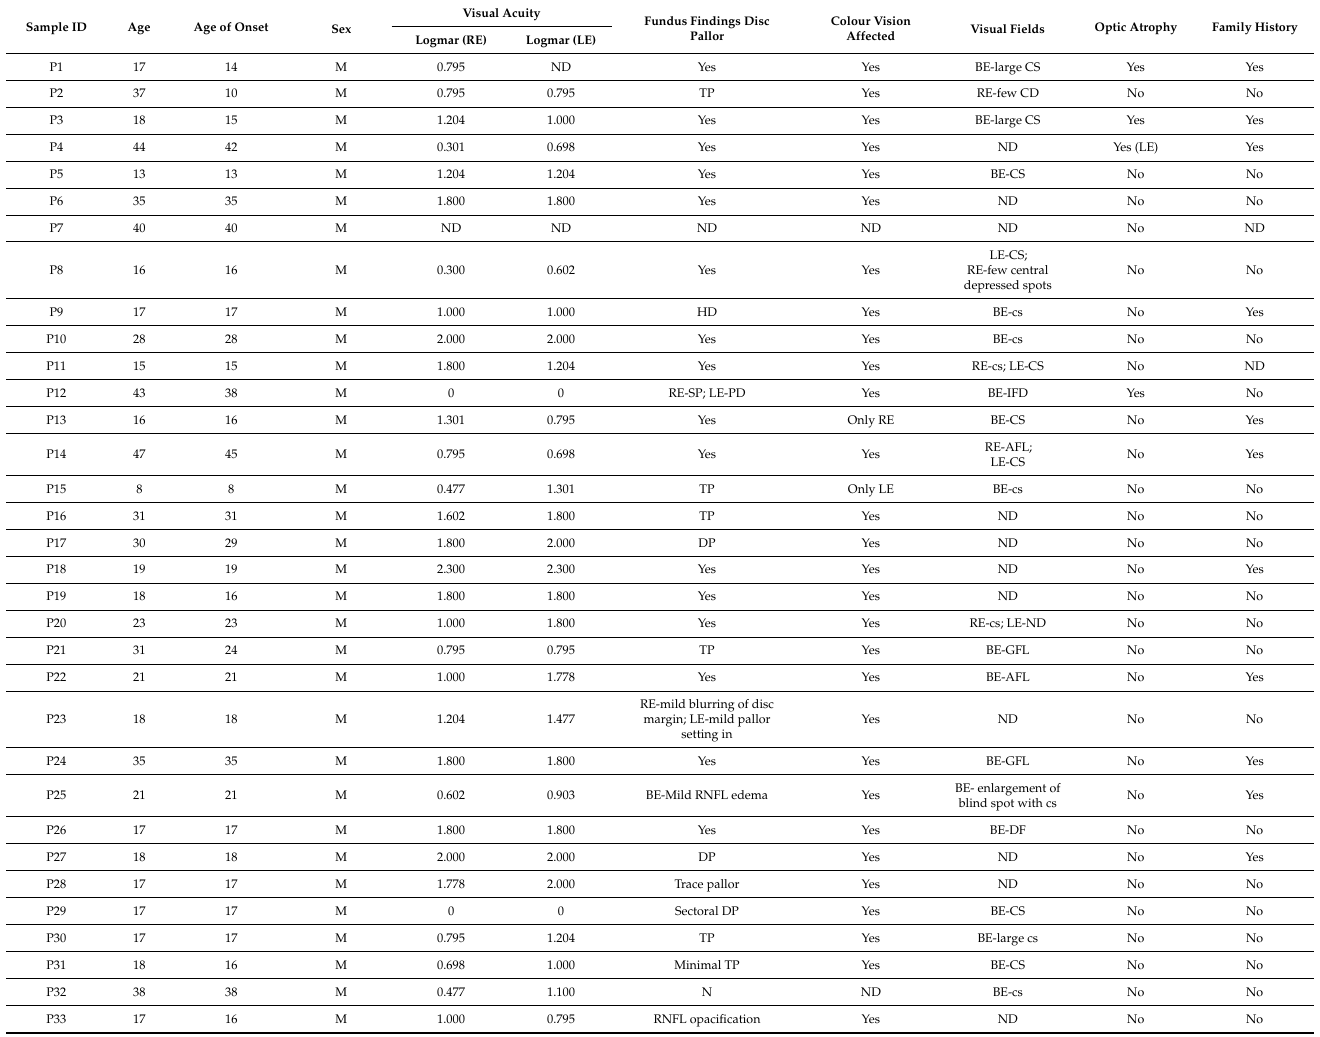
Table 1. Clinical details of the patients harbouring primary LHON